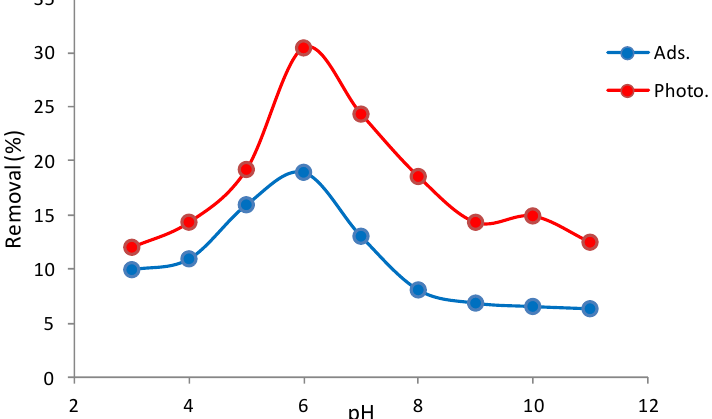
Fig. 4. Effect of pH for the removal of MB; initial concentration of MB (200 mg/L), T= 298 K, contact time 180 min for adsorption process and irradiation time (40 min) for photocatalytic degradation.